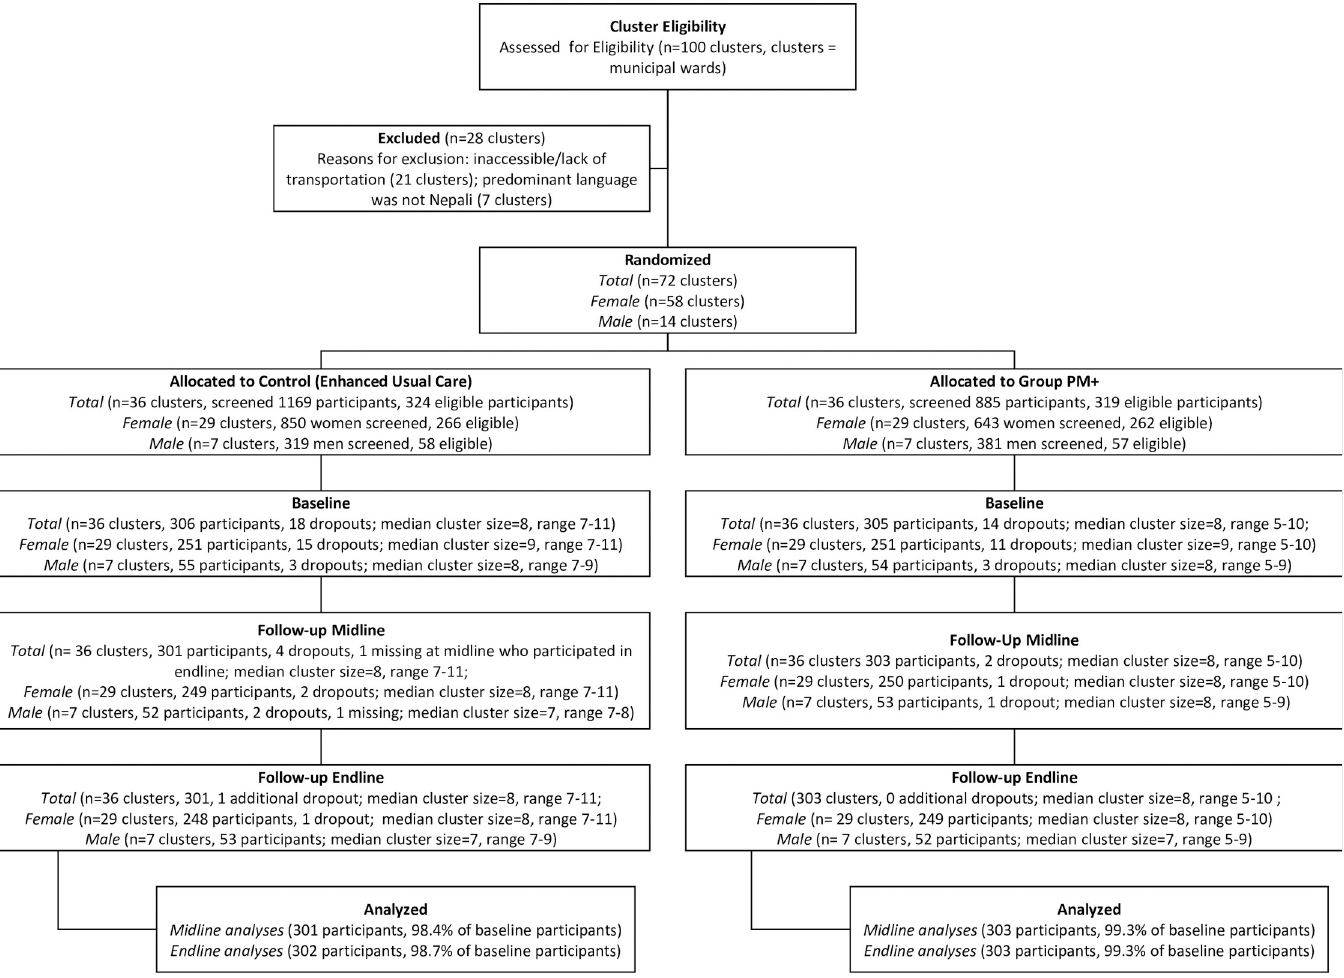
Fig 1. CONSORT flowchart for Group PM+ cRCT in community settings Morang, Nepal, conducted November 25, 2018 through September 30, 2019. Midline is 7 weeks post-baseline (after completion of the intervention in the Group PM+ arm). Endline is 20 weeks post-baseline (approximately 3 months after completion of the intervention in the Group PM+ arm). Group PM+ consists of 5 weekly group therapy sessions. EUC is a brief (30 minutes) family psychoeducation session and passive referrals to primary care–based mental health services. CONSORT, Consolidated Standards of Reporting Trials; cRCT, cluster randomized controlled trial; EUC, enhanced usual care; PM+, Problem Management